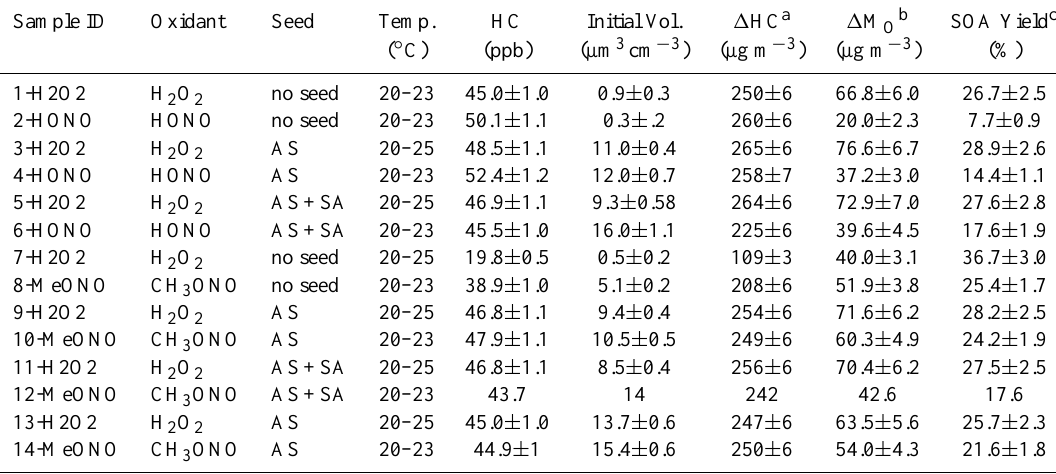
Table 1. SOA yields from low- and high-NO x photooxidation of α -pinene. Sample ID Oxidant Seed